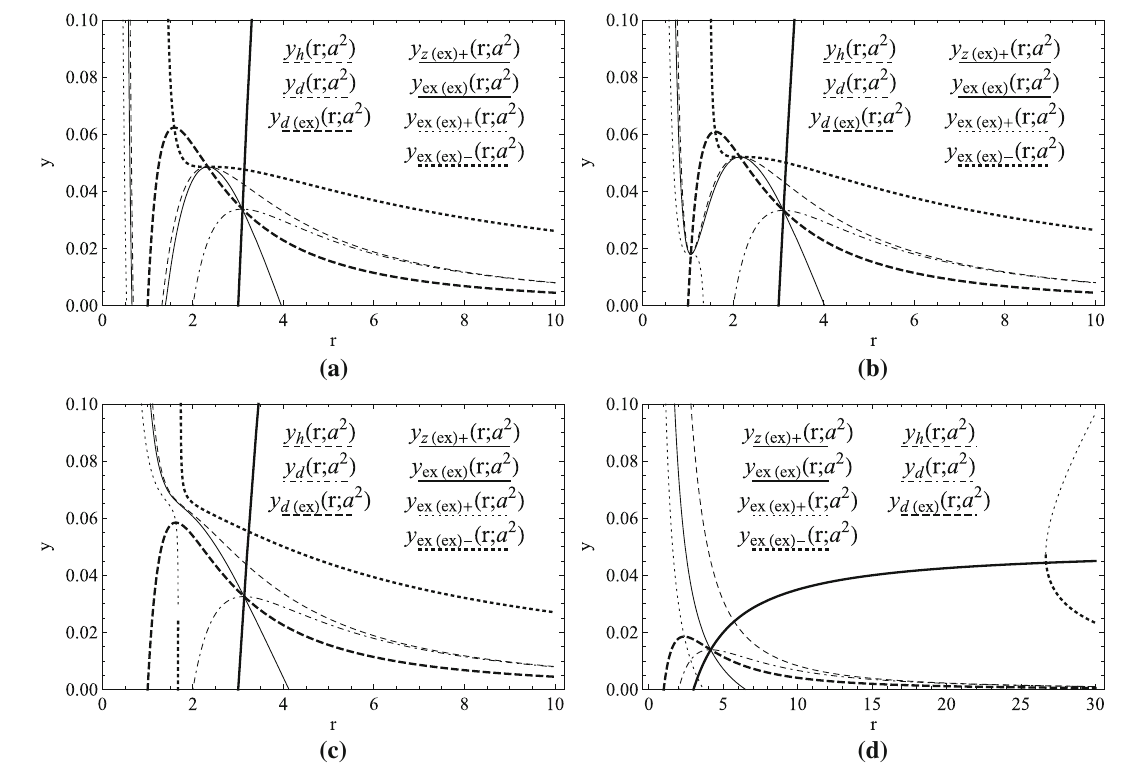
Fig. 6 Characteristic functions y ( r ; a 2 ) given for a 2 = 0 . 9 ( a ) a 2 = 1 . 04 ( b ), a 2 = 1 . 3 ( c ) and a 2 = 20 ( d )